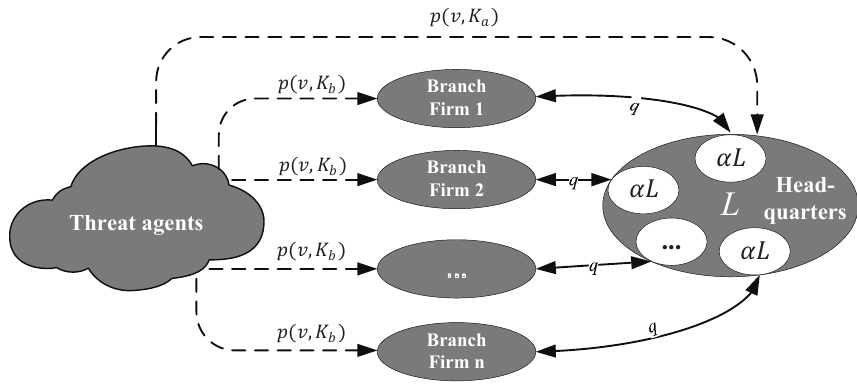
Figure 1. Conceptual model of